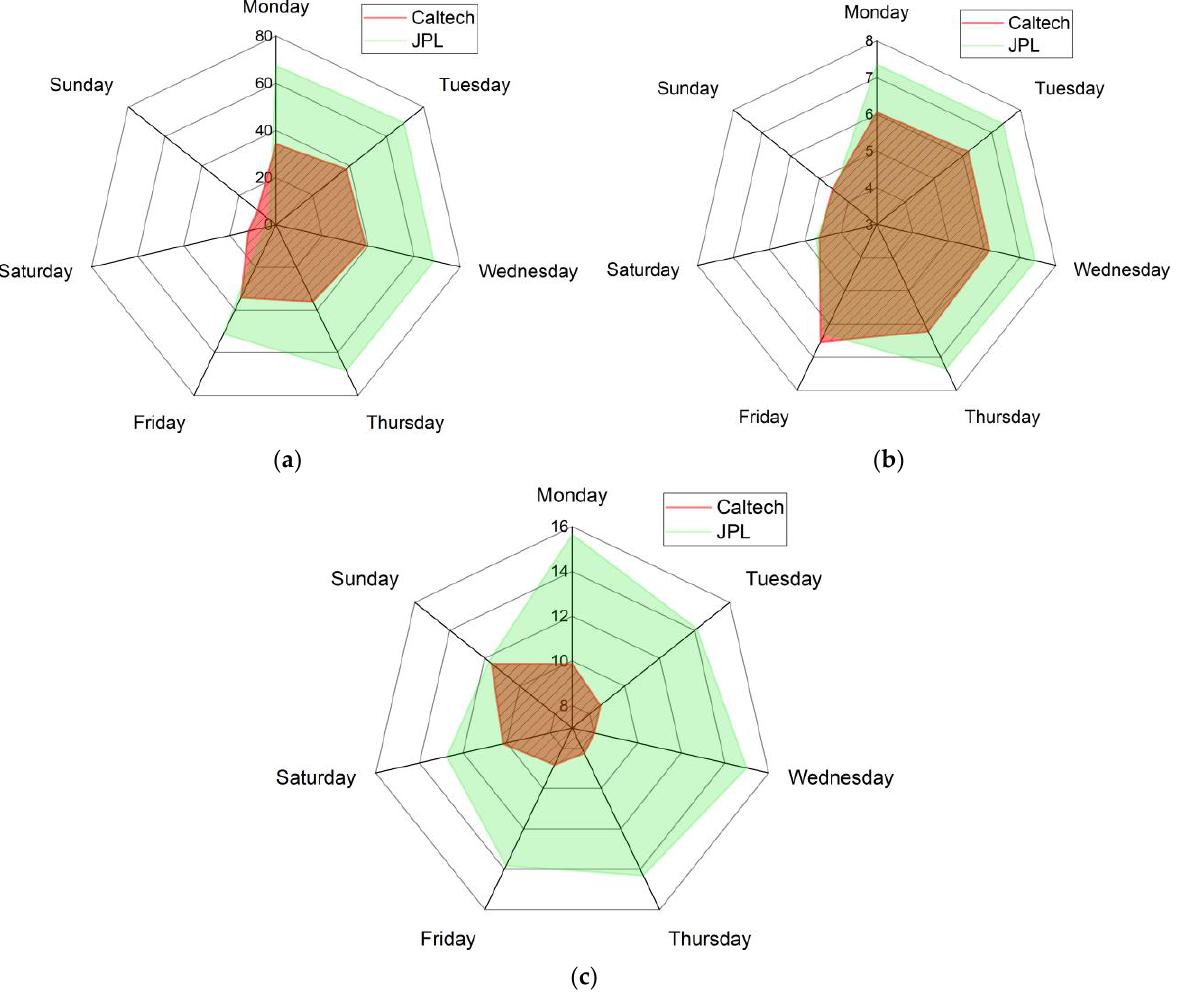
Figure 5. Change of charging behavior on different days of the week. ( a ) Number of average sessions. ( b ) Average session duration. ( c ) Average energy delivered per session.